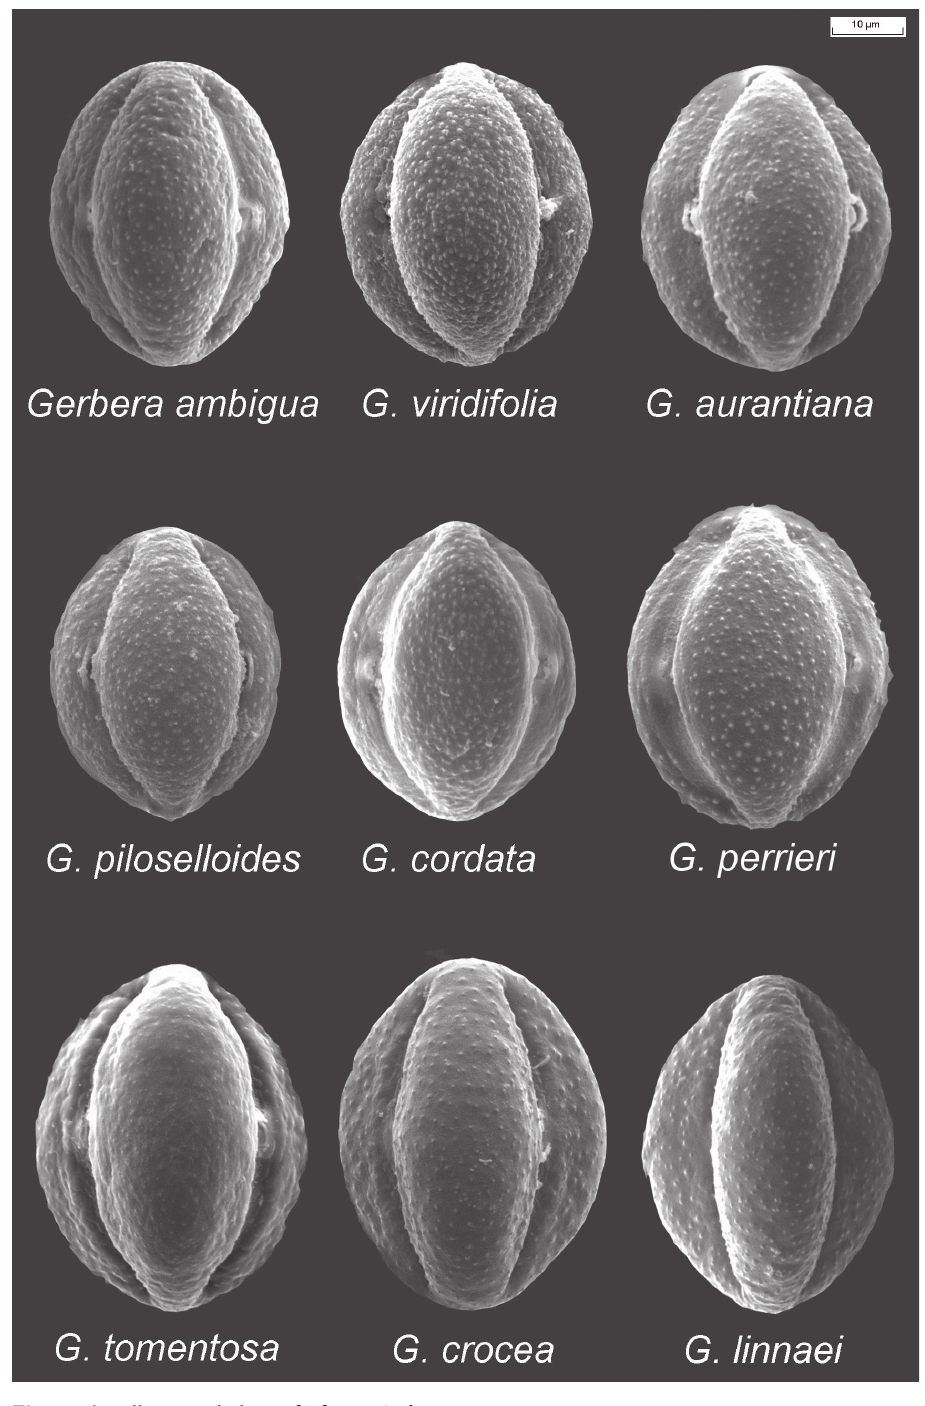
Figure 4. Pollen morphology of African Gerbera